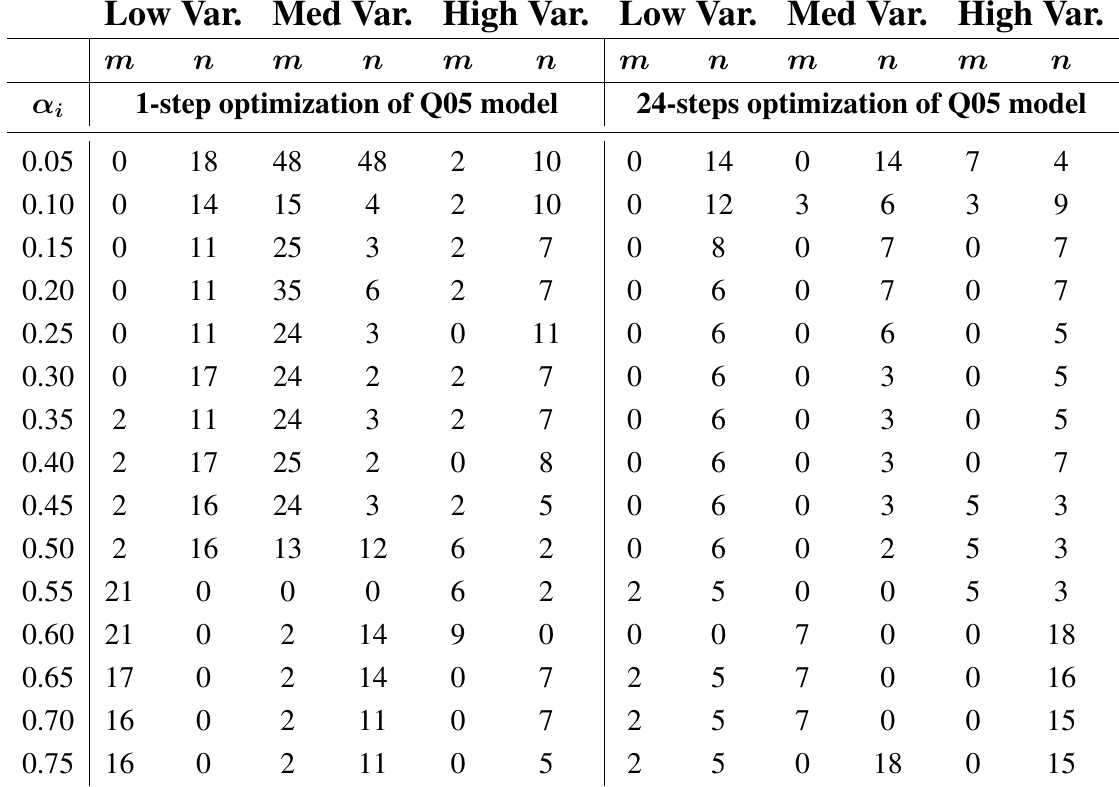
Table 5. 1-step and averaged over 24-steps CFS optimization results for the Q05 model of Equation